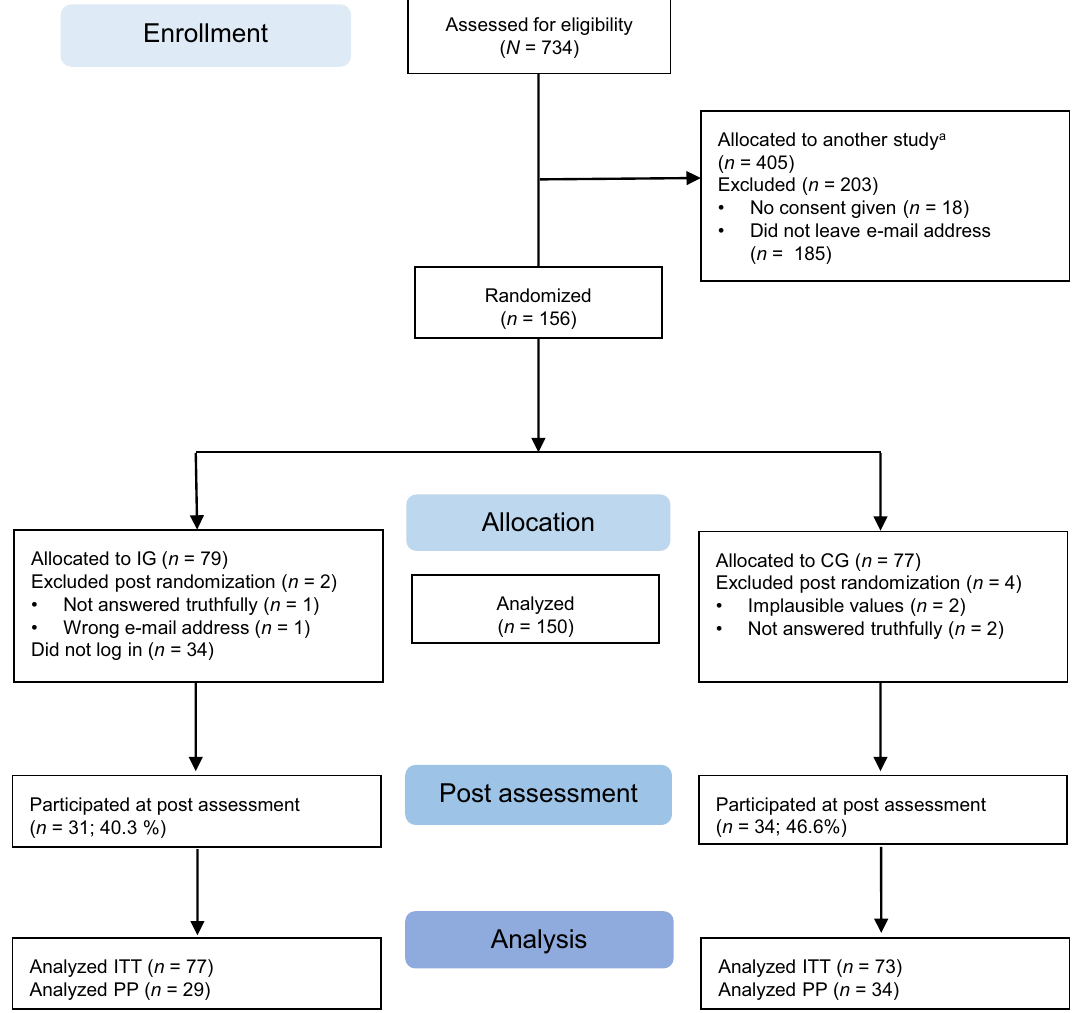
Figure 1. CONSORT